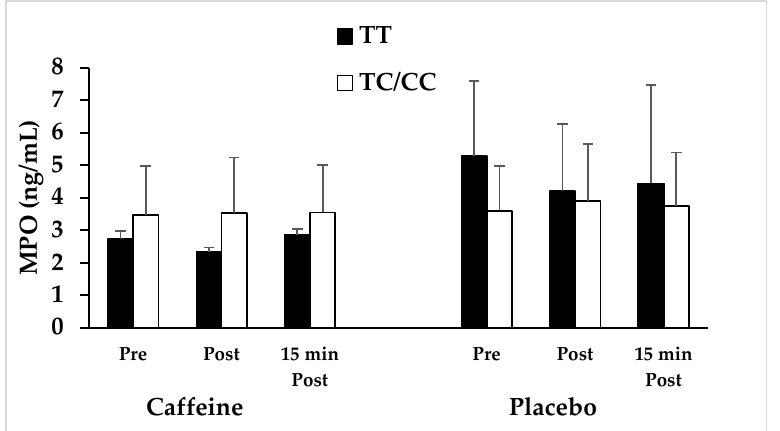
Figure 2. MPO response to resistance exercise in athletes with ADORA2A C allele and TT genotype following caffeine and placebo supplementation. No significant differences in the changes have been observed. MPO: myeloperoxidase.